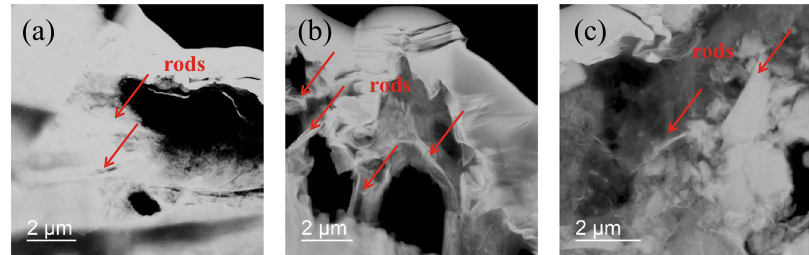
Fig. 10 HAADF-STEM images of the zircon sample thin fi lms with inner/outer detection angle of 110 – 440 mrad. The scale bar is 2 μ m.